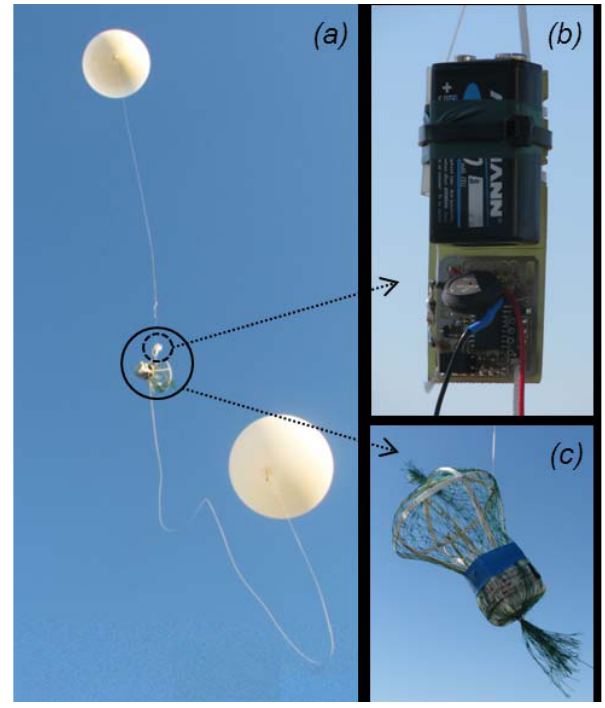
Fig. 2. Overview of the dual-balloon sounding system: (a) complete system, (b) separation device and (c) radiosonde protection